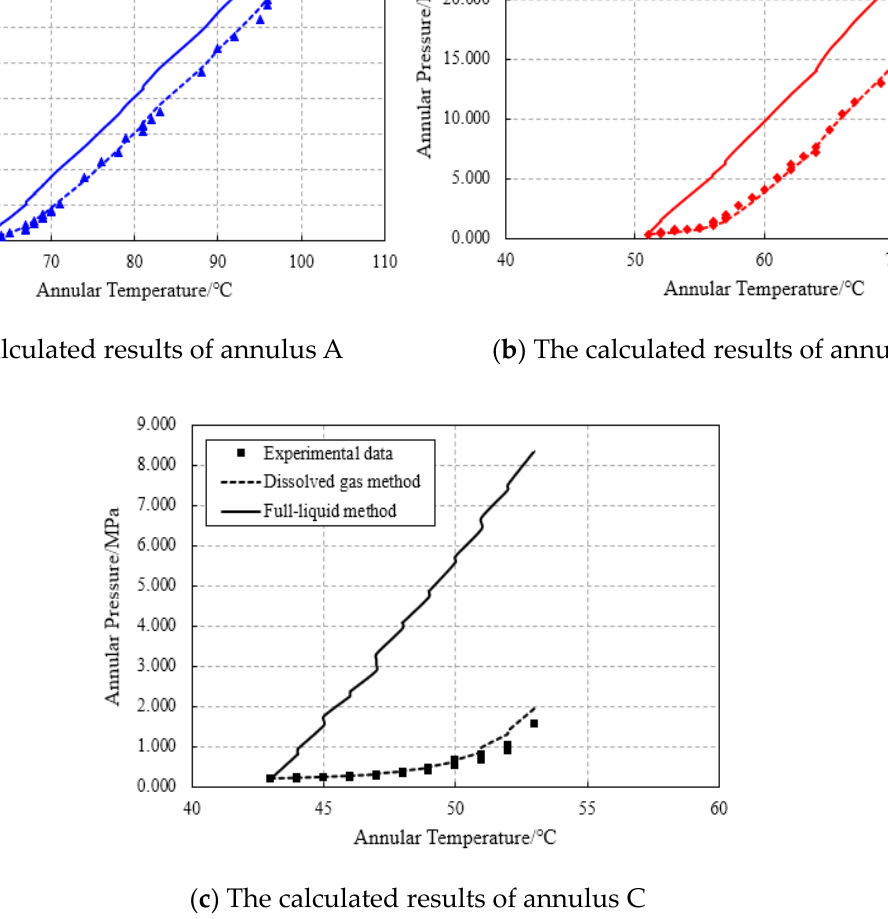
Figure 11. Comparison of the dissolved gas model simulations with experimental data and the full-liquid model results. The error analysis of the calculated results is shown in Table 6. Table 6. The error analysis of calculated results of the dissolved gas model.